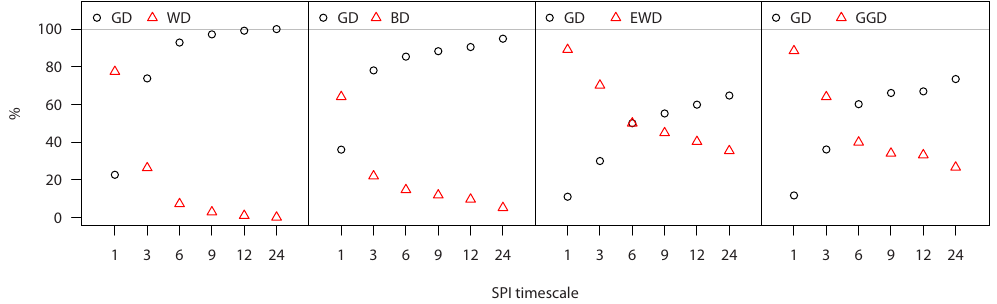
European region. The GD (black dots) is compared to the WD, BD, EWD and GGD (red triangles) in dependence of the SPI time